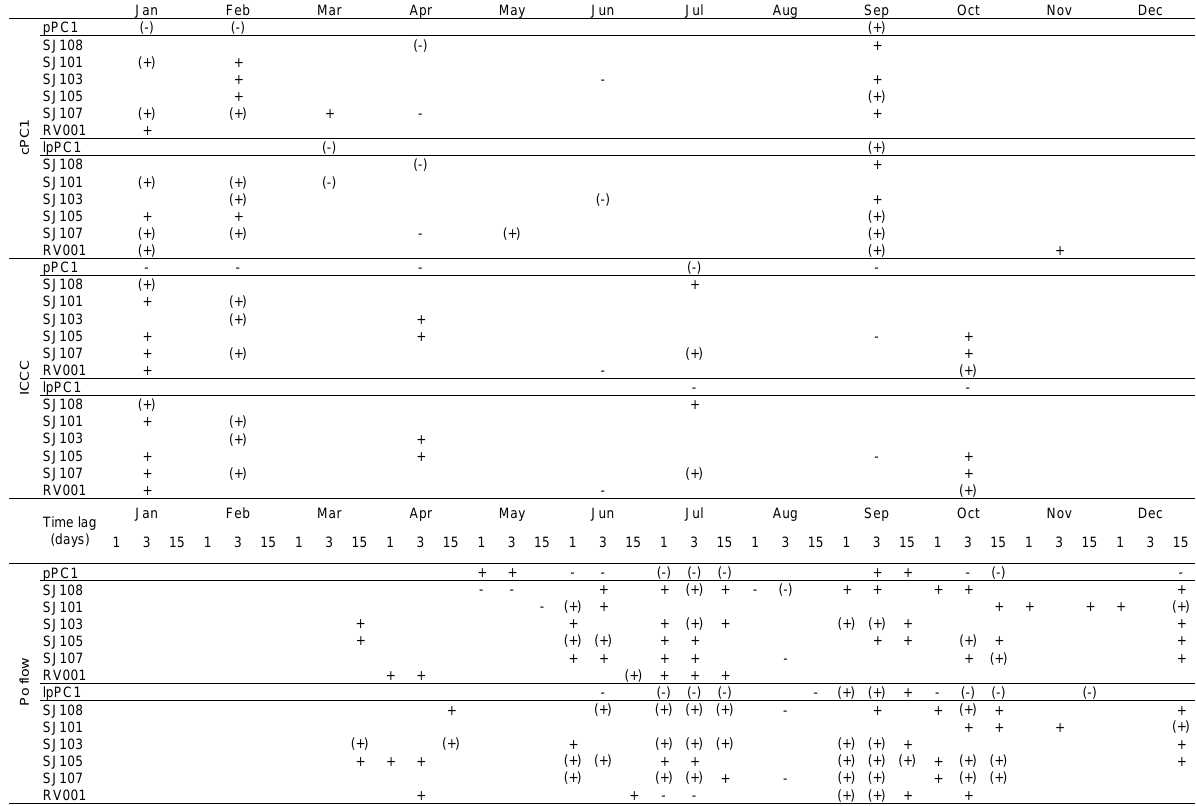
Table 1. Positive ( + ) or negative ( − ) correlation between changes in phytoplankton abundance (pPC1 scores or average water column values at SJ108, SJ101, SJ103, SJ105, SJ107 and RV001) during 1990–2004 and changes in (i) cPC1 scores, (ii) the ICCC and (iii) Po flow discharge rates 1, 3 and 15 days before the PA sampling, for original and log data. The signs and signs in parentheses indicate significances of 80 and 95%,